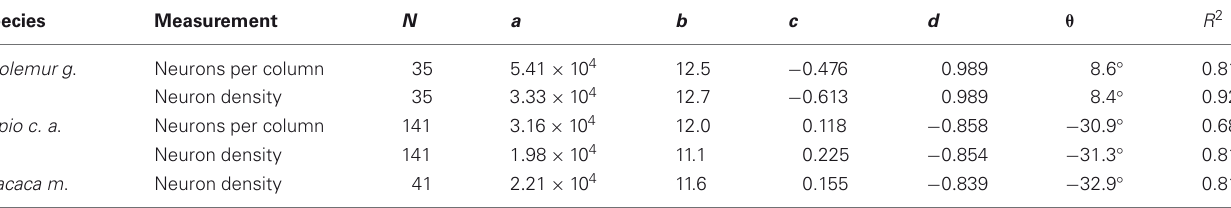
Table 5 | Parameters for fitting our two-factor model for baboon neuron density. Species Measurement N p N np a b c d e θ R 2 Papio c. a . Neuron density 25